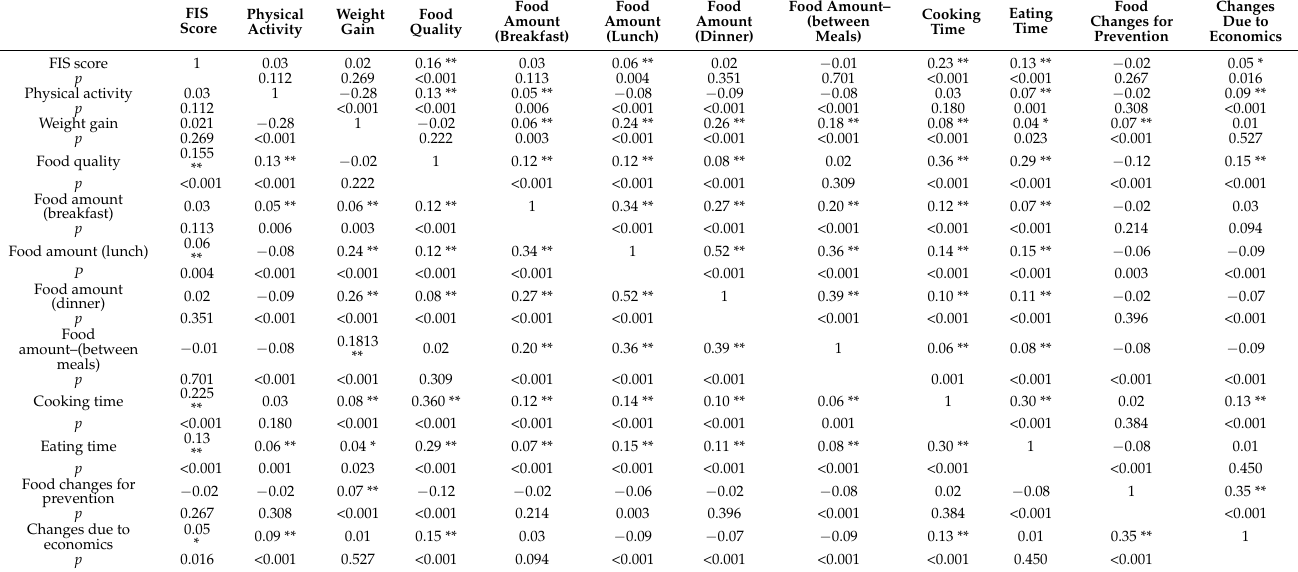
Table 3. Pearson’s correlation coefficients on general habit changes during the COVID-19 pandemic and FIS score. * p < 0.05 level; ** p <